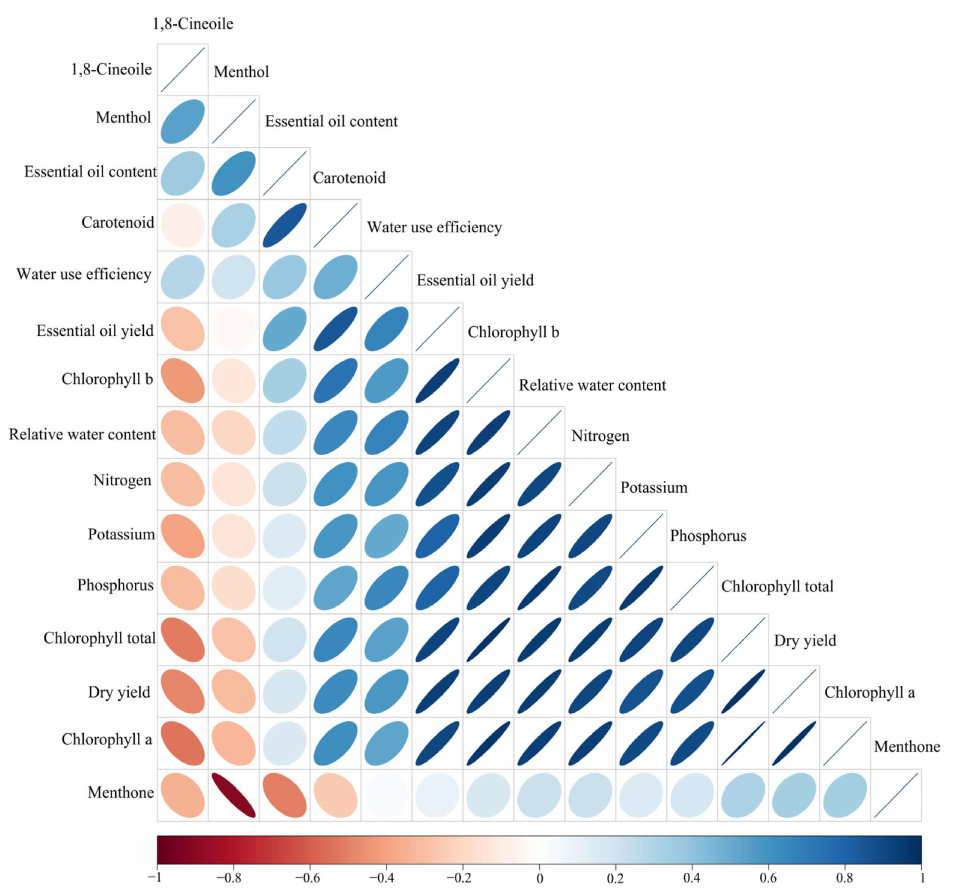
Figure 7. Pearson’s correlation matrix for studied traits of peppermint. Color ellipses illustrate statistically significant levels. Positive and negative correlations are shown with blue and red, respectively. The color legend on the bottom hand side of the corrplot represented intensities Pearson correlation